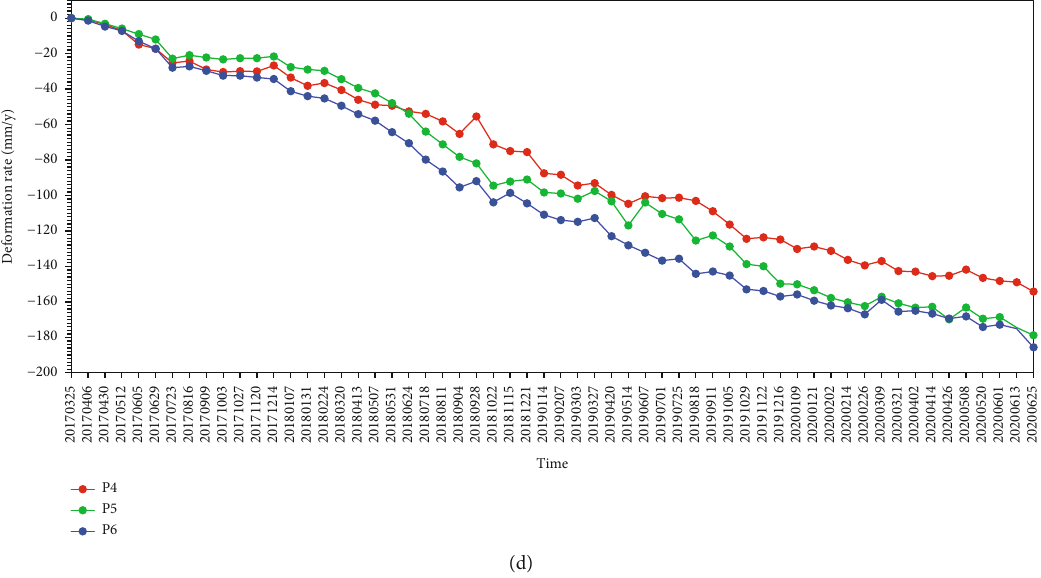
Figure 10: (a) The average annual deformation rate distribution of strong deformation zone A (2017.3-2020.6). (b) The average annual deformation rate distribution of strong deformation zone B (2017.3-2020.6). (c) Time series deformation diagram of characteristic point A in strong deformation zone. (d) Time series deformation diagram of characteristic point B in strong deformation zone.